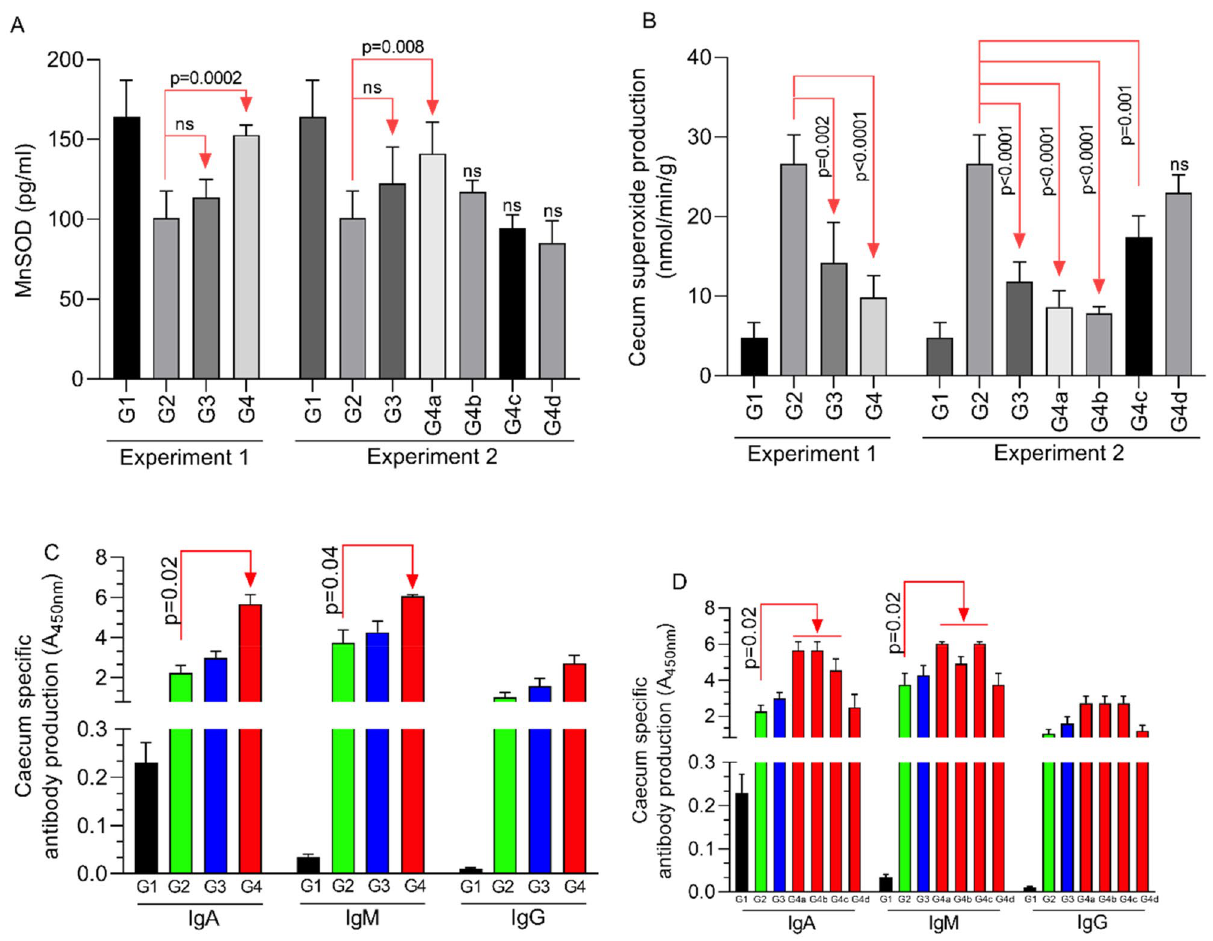
Figure 3. The in vivo impact of the antimicrobial mixture (AG) on MnSOD, superoxide and antibody production levels in the caecal tissue. In ( A ) the levels of MnSOD are shown with the levels of ROS detected in the caecal tissue in ( B ). ( C ) The levels of IgA, IgM and IgG during Experiment 1 followed by the levels of IgA, IgM and IgG in Experiment 2 shown in ( D ). All measurements were performed in triplicate and p values are indicated on the graphs indicating significance.